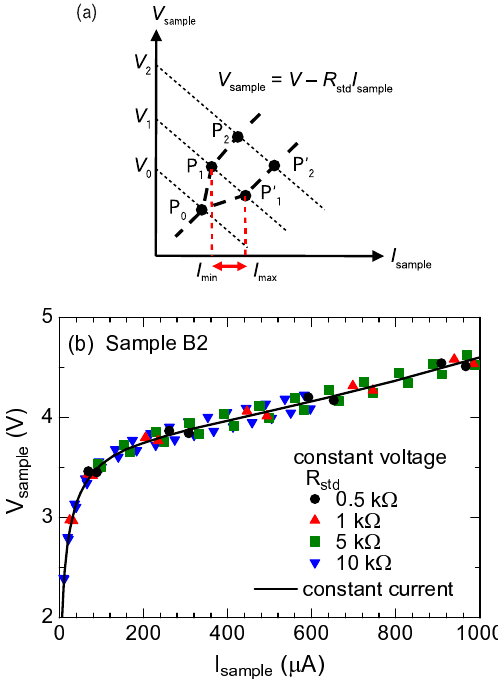
Figure 4 . (a) Schematic figure of the operating points in the current-voltage plane (see text). (b) Operating points determined from the experimental data of Sample B2. The solid curve represents the voltage-current characteristics measured in constant